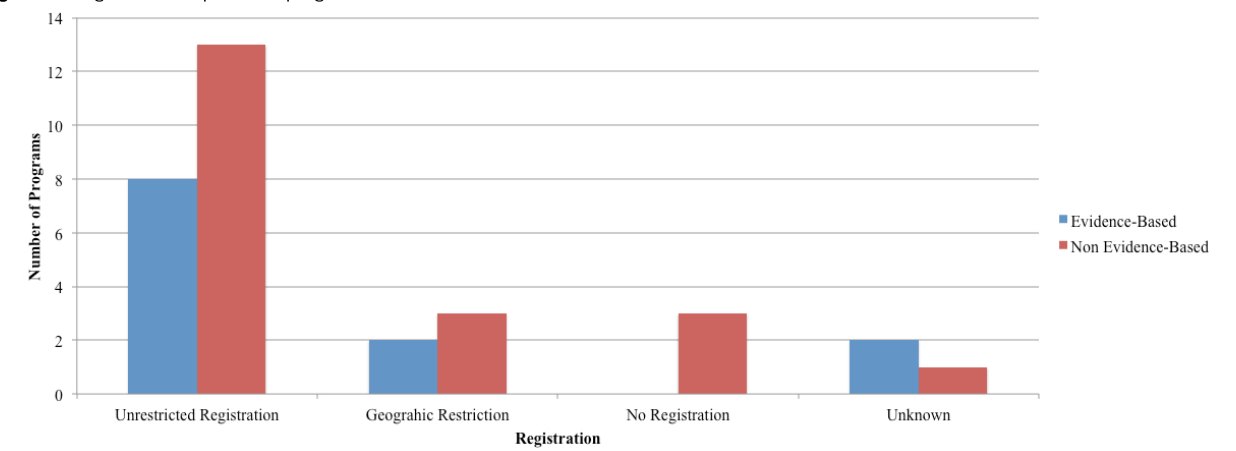
Figure 3. Registration required for program